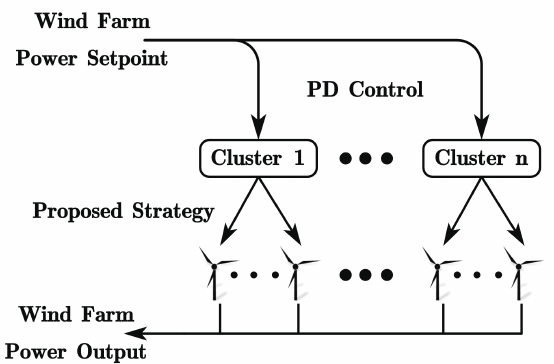
Figure 3. Wind farm control structure. Proportional distribution